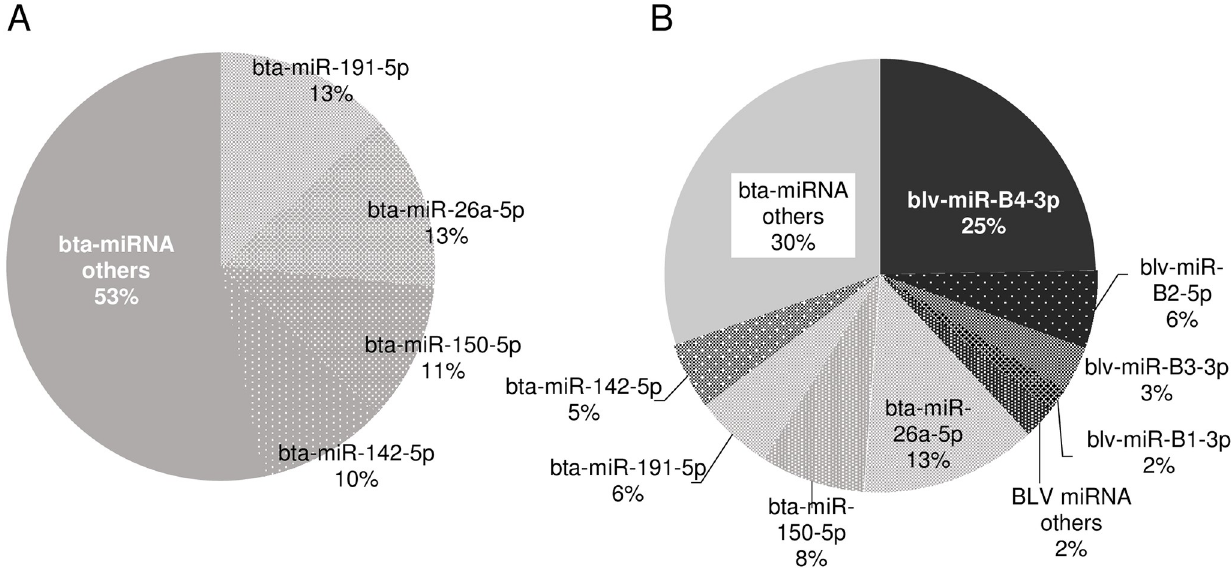
Fig 1. Percentage of miRNAs expressed in B cells derived from BLV-infected cattle and healthy cattle without BLV infection. The average ratios of miRNAs expressed in B cells made up of bovine-derived miRNA (bta-miRNA) and/or BLV-derived miRNA (blv-miRNA) were calculated. (A) Healthy cattle without BLV infection, (B) BLV-infected